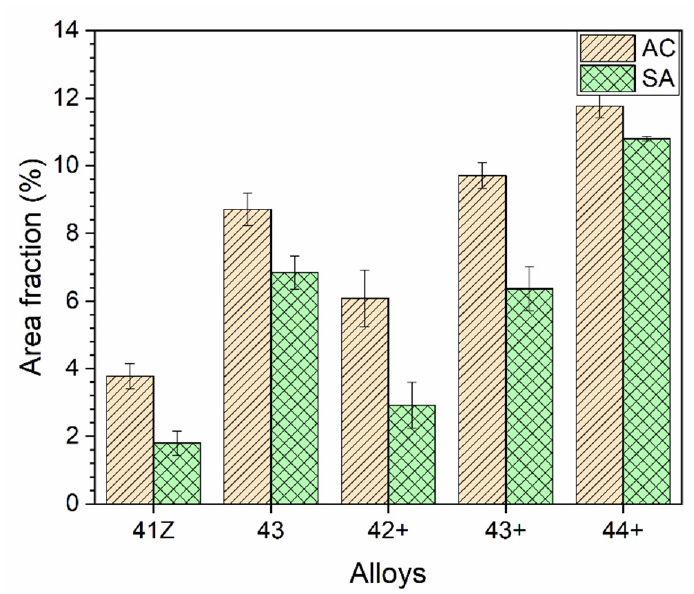
Figure 4. Area fraction of the B2-NiAl phases for the developed alloys in as-cast and solution annealed conditions.